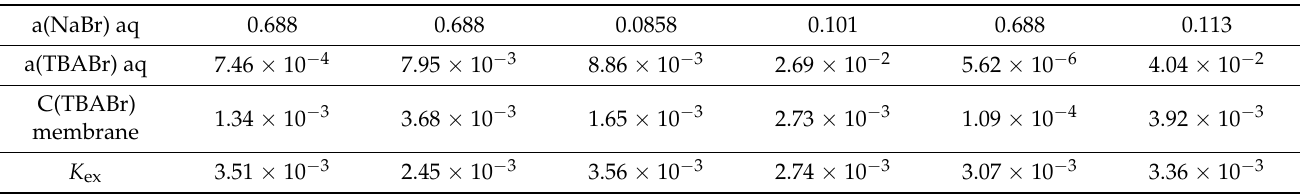
Table A1. The equilibrium TBABr concentrations in the membrane phase, activities in water solution, and calculated coextraction constants.